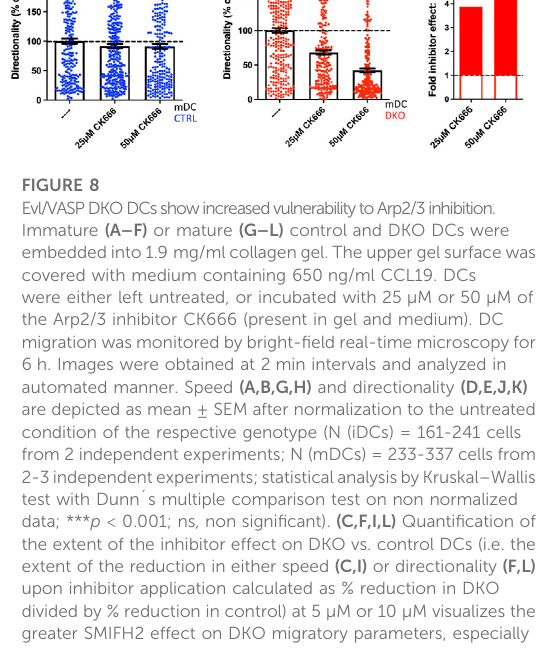
data; *** p < 0.001; ns, non signi fi cant). (C,F,I,L) Quanti fi cation of the extent of the inhibitor effect on DKO vs. control DCs (i.e. the extent of the reduction in either speed (C,I) or directionality (F,L) upon inhibitor application calculated as % reduction in DKO divided by % reduction in control) at 5 µM or 10 µM visualizes the greater SMIFH2 effect on DKO migratory parameters,